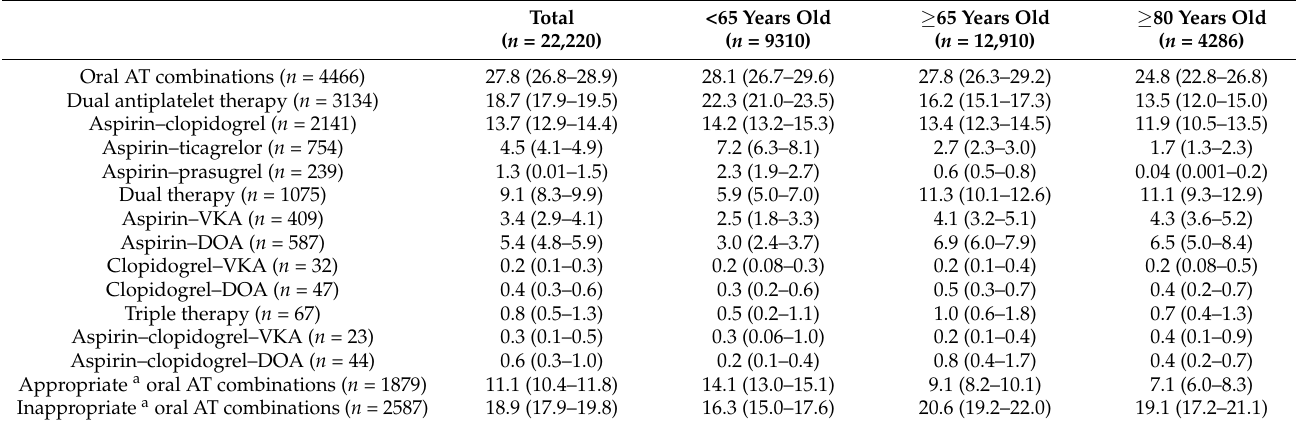
Table 2. Cumulative incidence (%, 95% confidence interval) at 5 years of oral antithrombotic (AT) combinations considering the competitive risk of death ( n = 1090), for the whole population ( n = 22,220) and stratified by age.